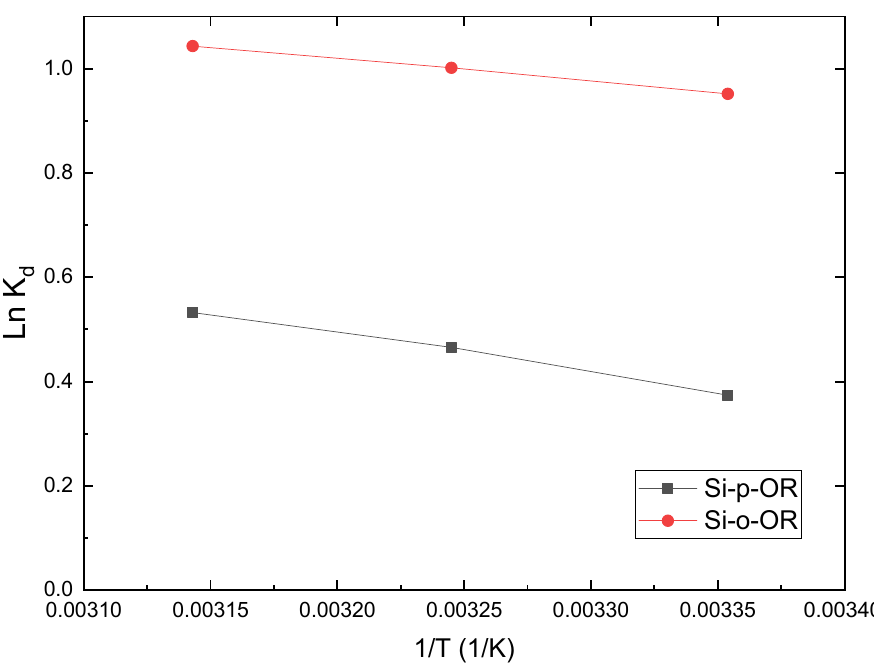
Figure 9. Linear plots of K d versus 1/ T for Cu(II) adsorption on Si-o-OR and Si-p-OR. Table 3. Thermodynamic parameters of Cu(II) using Si-o-OR and Si-p-OR.